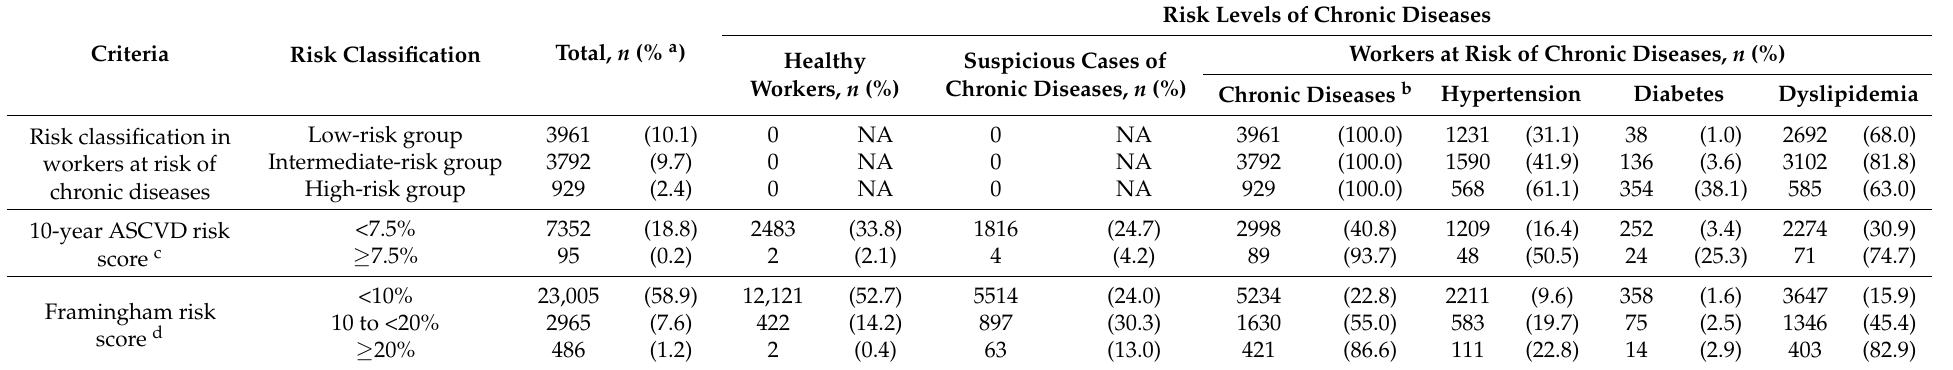
Table 2. Correlation among health risk classifications in employees of the semiconductor/liquid crystal display (LCD)